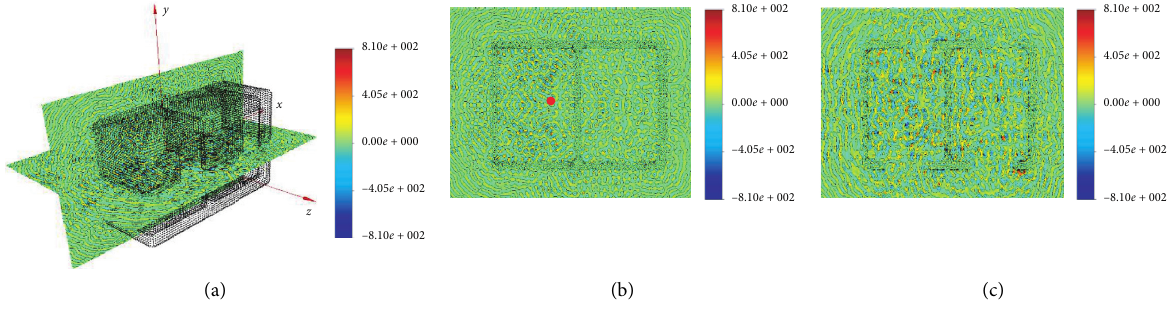
Figure 12: The isometric (a), x - y plane (b), and x - z plane (c) view of the rooms for the source location ( − 0.4 m, 0,